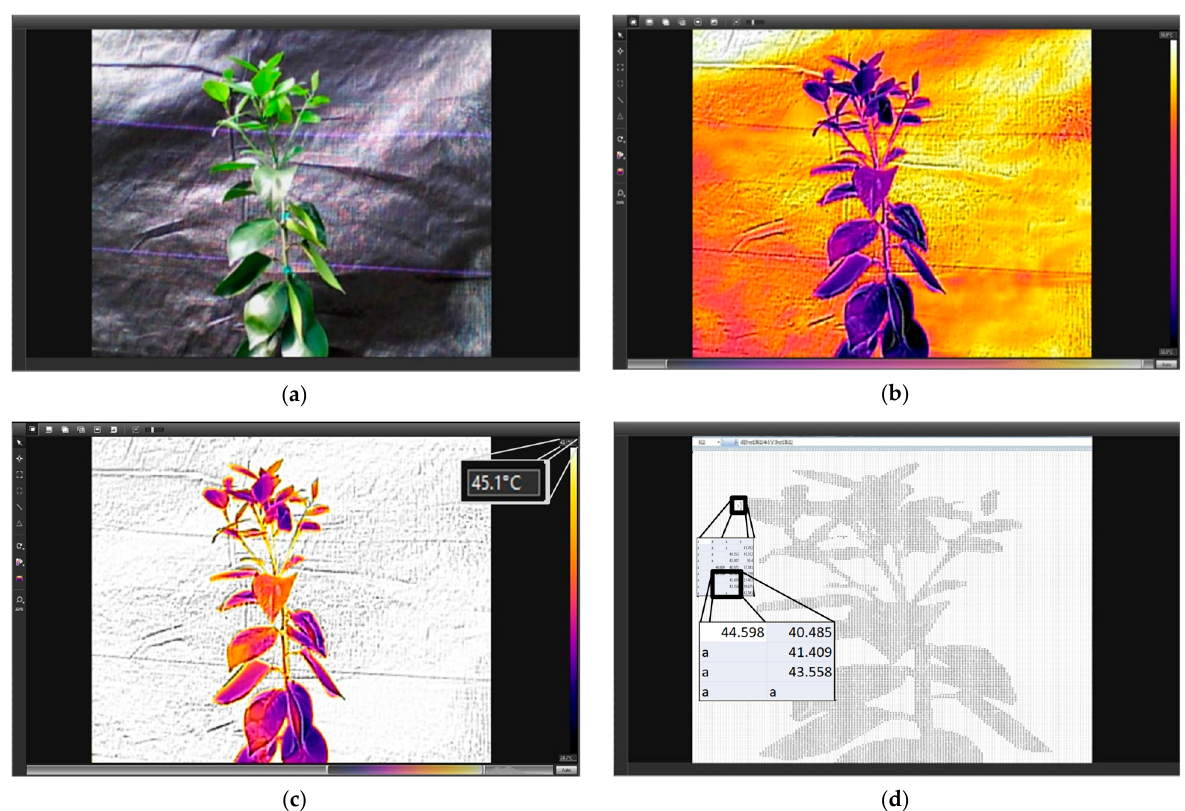
Figure 4. ( a ) Digital image of a one-year-old citrus plant with a black screen background. Thermal images before ( b ) and after ( c ) the threshold temperature adjustment made by the software and the temperature value showed on the upper right corner. ( d ) Spreadsheet with the separated values (numbers vs. letters) showing the silhouette of the plant.